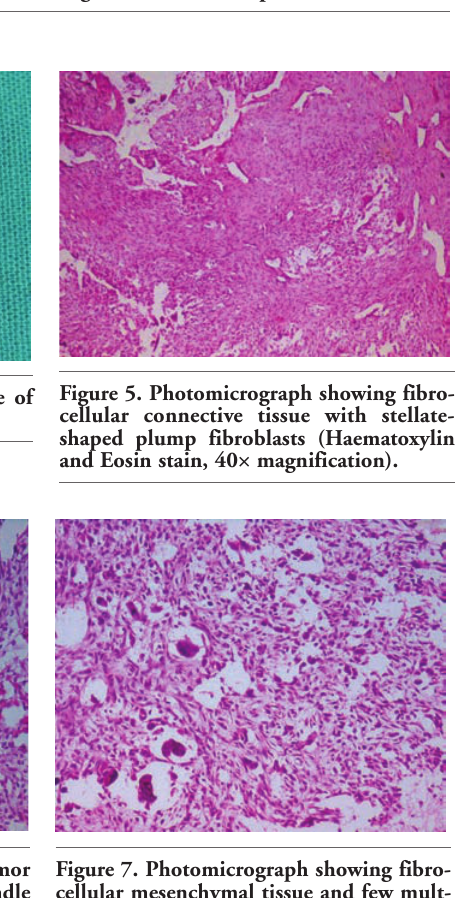
Figure 3. Occlusal and IOPA radiographs revealed a radiolucent mass in the mandibular inci- sor area displacing 31 and 41 laterally and resorbing the buccal cortical plate of the mandible.